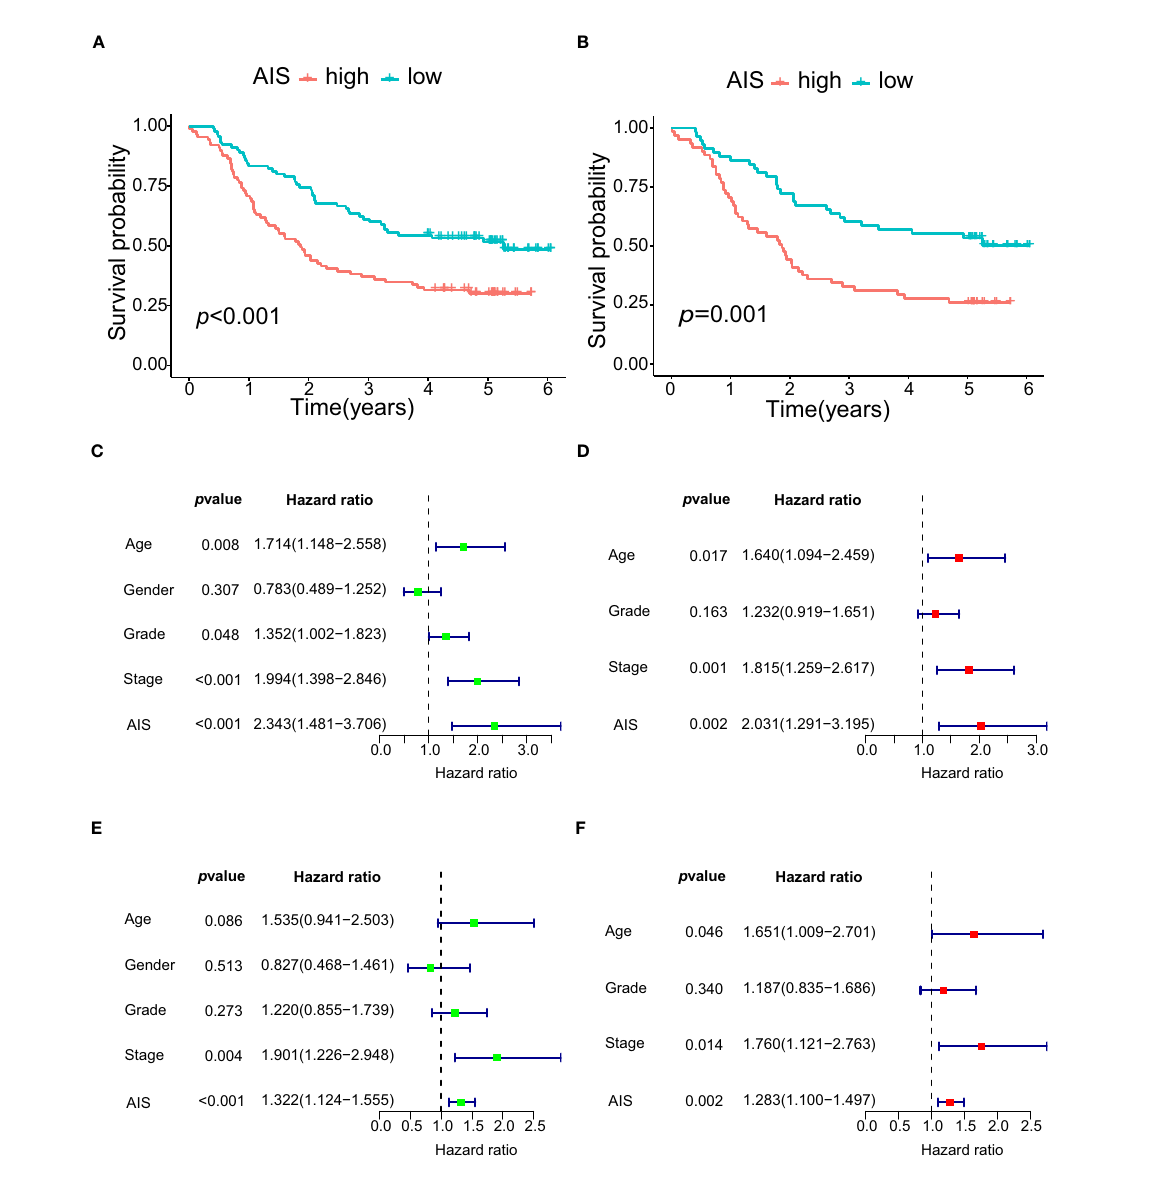
FIGURE 9 The survival and COX regression analyses of OS according to AIS. (A) Kaplan-Meier curve of OS for high- AIS and low- AIS groups in GSE53625. (B) Kaplan-Meier curve of OS for high- AIS and low- AIS groups in GSE53624. (C) Univariate Cox regression analysis of OS according to AIS in GSE53625. (D) Multivariate Cox regression analysis of OS according to AIS in GSE53625. (E) Univariate Cox regression analysis of OS according to AIS in GSE53624. (F) Multivariate Cox regression analysis of OS according to AIS in